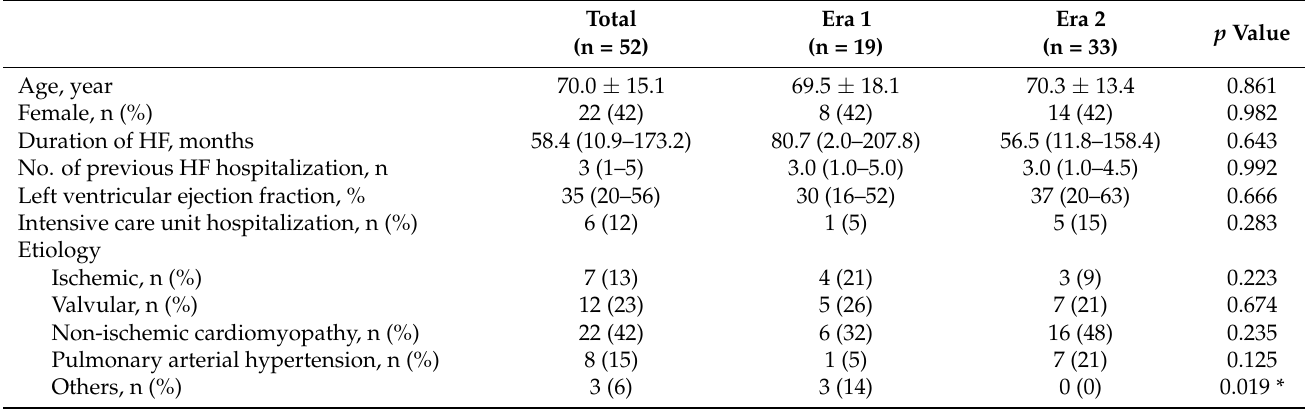
Table 1. Baseline characteristics of